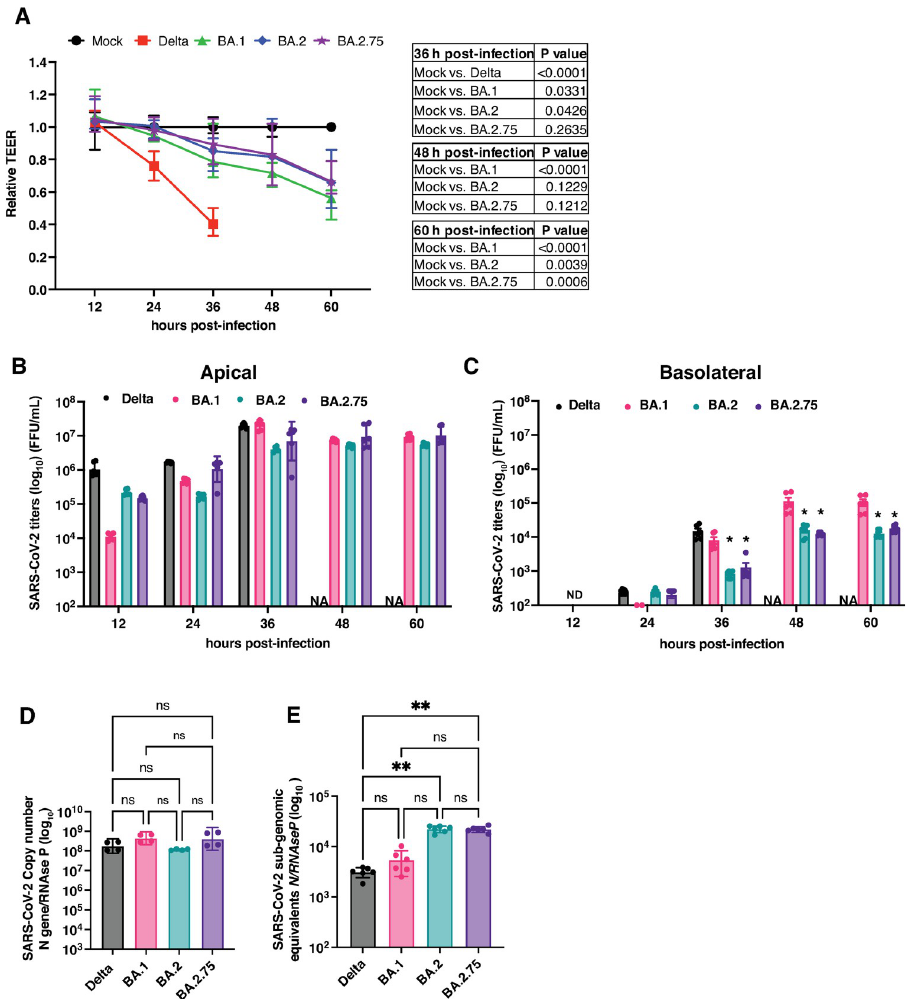
Fig 5. Sub-lineages of Omicron variant have milder effects on epithelial junctions. Calu-3 cells were grown on transwell inserts under air-liquid interface (ALI) conditions. Cells were infected with the indicated SARS-CoV-2 variants at 0.3 MOI. (A) Graph indicates TEER values relative to mock infection at indicated time points from two independent experiments (Mean and error with range). Statistical significance was estimated by two-way ANOVA with Tukey’s multiple comparisons test. Transwells with delta variant were discontinued at 36 h pi and therefore are indicated as NA at later points. (B) Viral titers in apical and (C) basolateral supernatants collected at indicated time points was estimated by focus-forming unit assay. Error bars represent geometric mean with 95% confidence intervals. ND: Not detected. � indicates P < 0.05 relative to BA.1 sub-lineage obtained by two-way ANOVA with Dunnett’s multiple comparison test. (D) Viral RNA levels in 1000 PFU of stock viruses of indicated SARS-CoV-2 variants was quantitated by qRT-PCR. (E) Calu-3 cells were infected with 10 5 genome equivalents of indicated SARS-CoV-2 variants and the amount of internalized RNA was estimated by RT-qPCR 1 h pi. Data are from two independent experiments. Error bars represent geometric mean with 95% CI. Statistical significance was estimated by Kruskal- Wallis test with Dunn’s multiple comparison test. ns: non-significant, � P < 0.05, �� P <